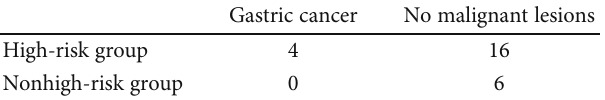
Table 7: Compare the number of GC patients in high-risk group and nonhigh-risk